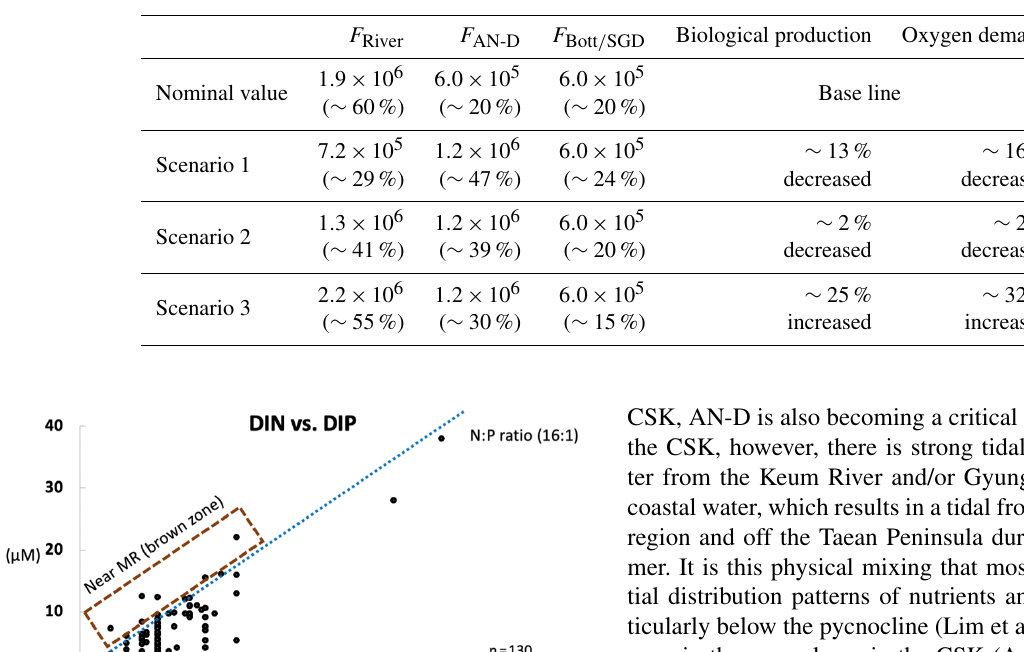
Table 5. Simulation results for selected model scenarios based on CSK (February 2008) data. Biological production is calculated by our N mass balance model. Oxygen demand is calculated by the Redfield stoichiometry ratio (C: − O 2 = 106 : 138; unit: gCm − 2 d − 1 ).